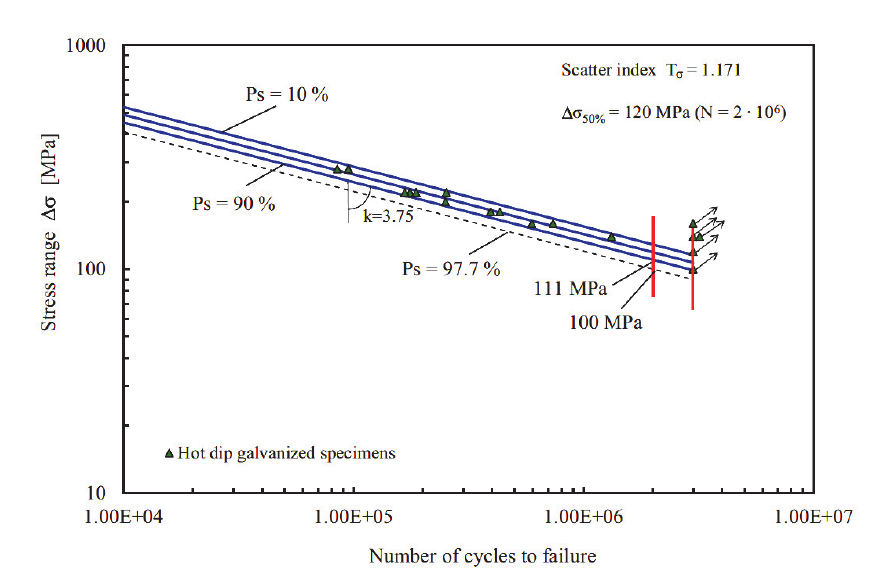
Figure 7: S-N-curves of hot dip galvanized connections.